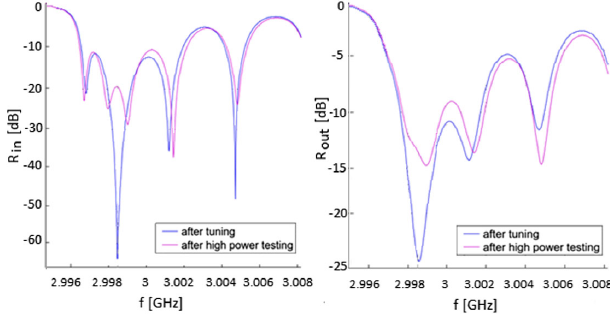
FIG. 17. A comparison of input (left) and output (right) reflection before and after high power testing.